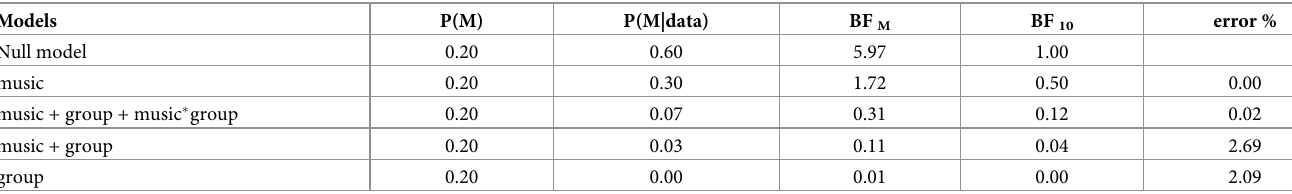
Table 6. Comparison of Bayes models: Music & group.